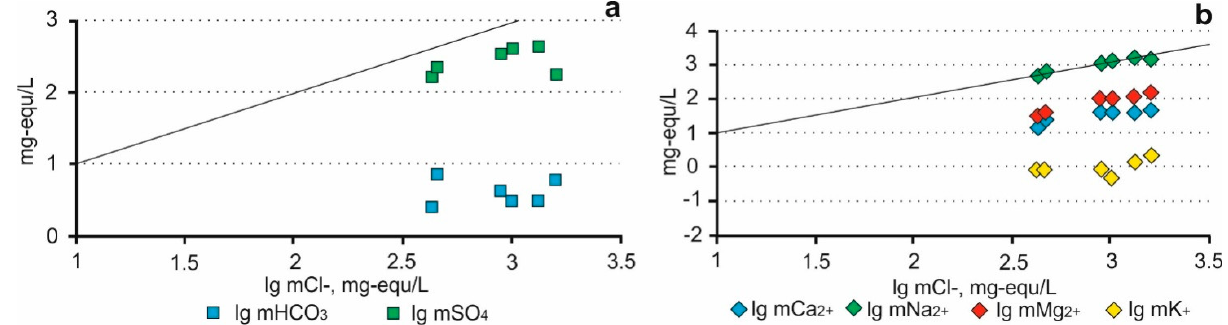
Figure 8. Dependence of the concentrations of the main anions ( a ) and cations ( b ) on the concentration of the chloride ion in Lake Taloe waters. A line with an inclination of 45° corresponds to the position of the points expected for simple evaporation.